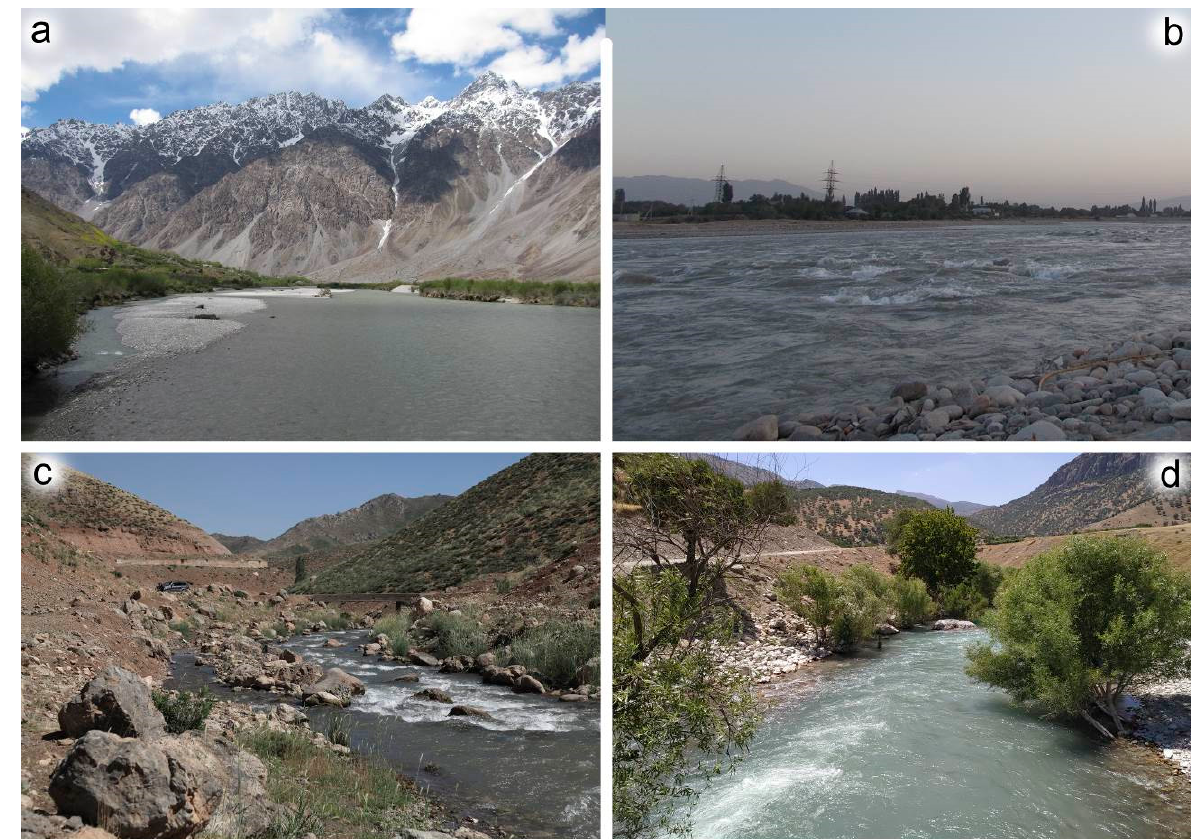
Figure 11. Habitats of Serratella leonidi Martynov & Palatov, sp. nov. ( a , b ) and Torleya elissa (Jacobus, Zhou & McCafferty, 2009) ( c , d ): ( a ) Pyandzh River (Tajikistan, June 2016), ( b ) Kofarnihon (=Kafirni- gan) River (Tajikistan, June 2016), ( c ) nameless river—left tributaries of the Tenge-Gendumer-Darre- Luku River (Iran, June 2019), ( d ) Tenge-Kholeven River (Iran, June